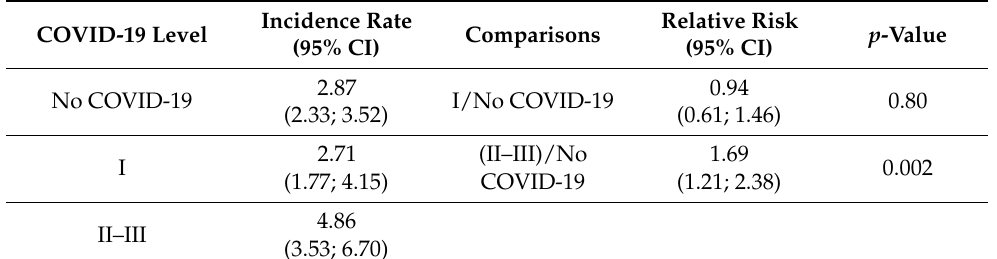
Table 3. Injury Incidence Rate, expressed as the expected number of injuries per 1000 h/player of exposure (training or competition). Estimates and comparisons were computed by a GLMM model.